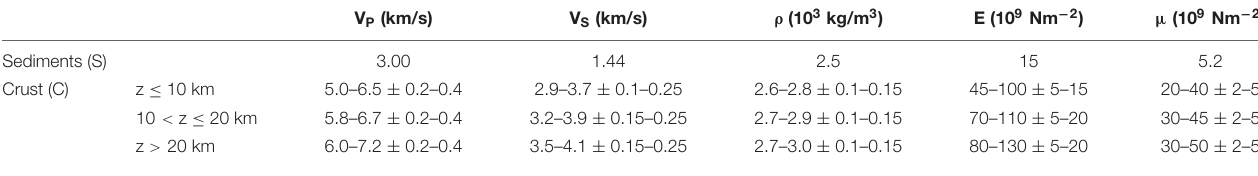
TABLE 2 | Variability of the geophysical properties of the layers.